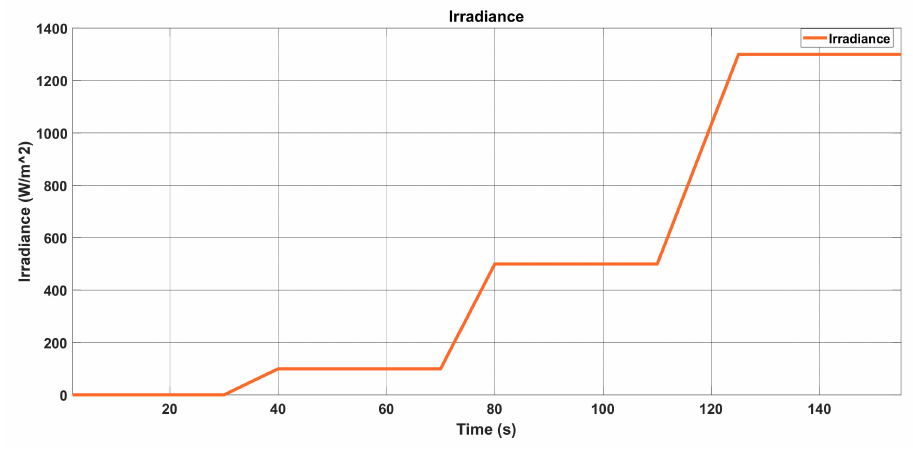
Figure 11. Irradiance profile.